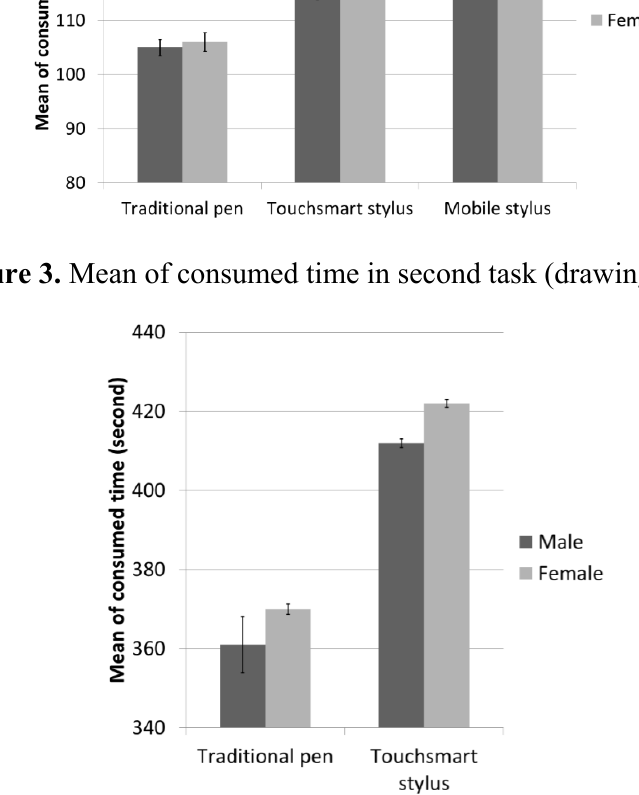
Figure 4. Mean of consumed time in third task (writing a